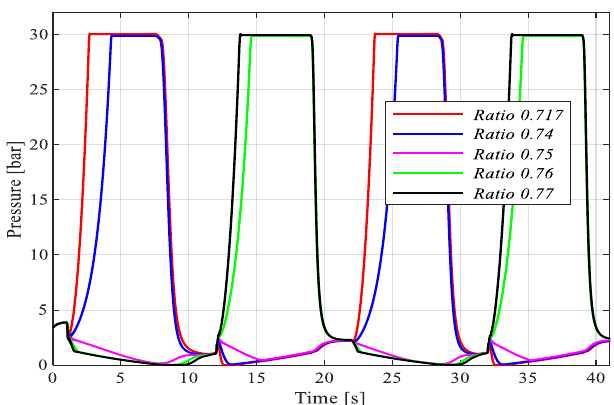
Figure 14. Pressure in the rod chamber for different displacement ratios. Cracking pressure = 30 bar.